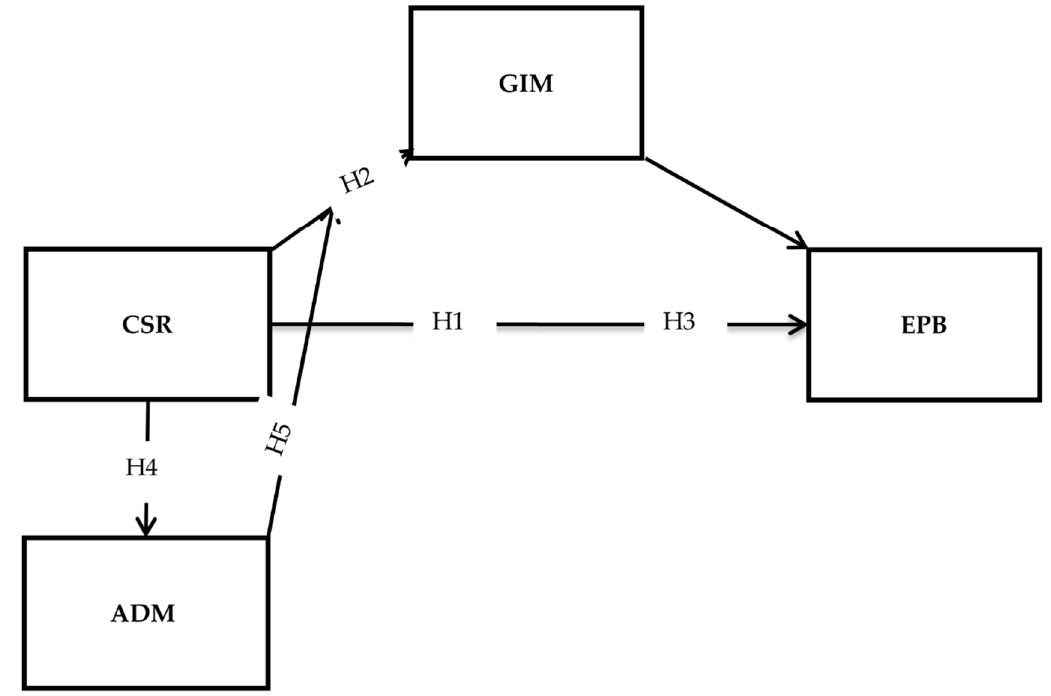
Figure 1. The hypothesized model .